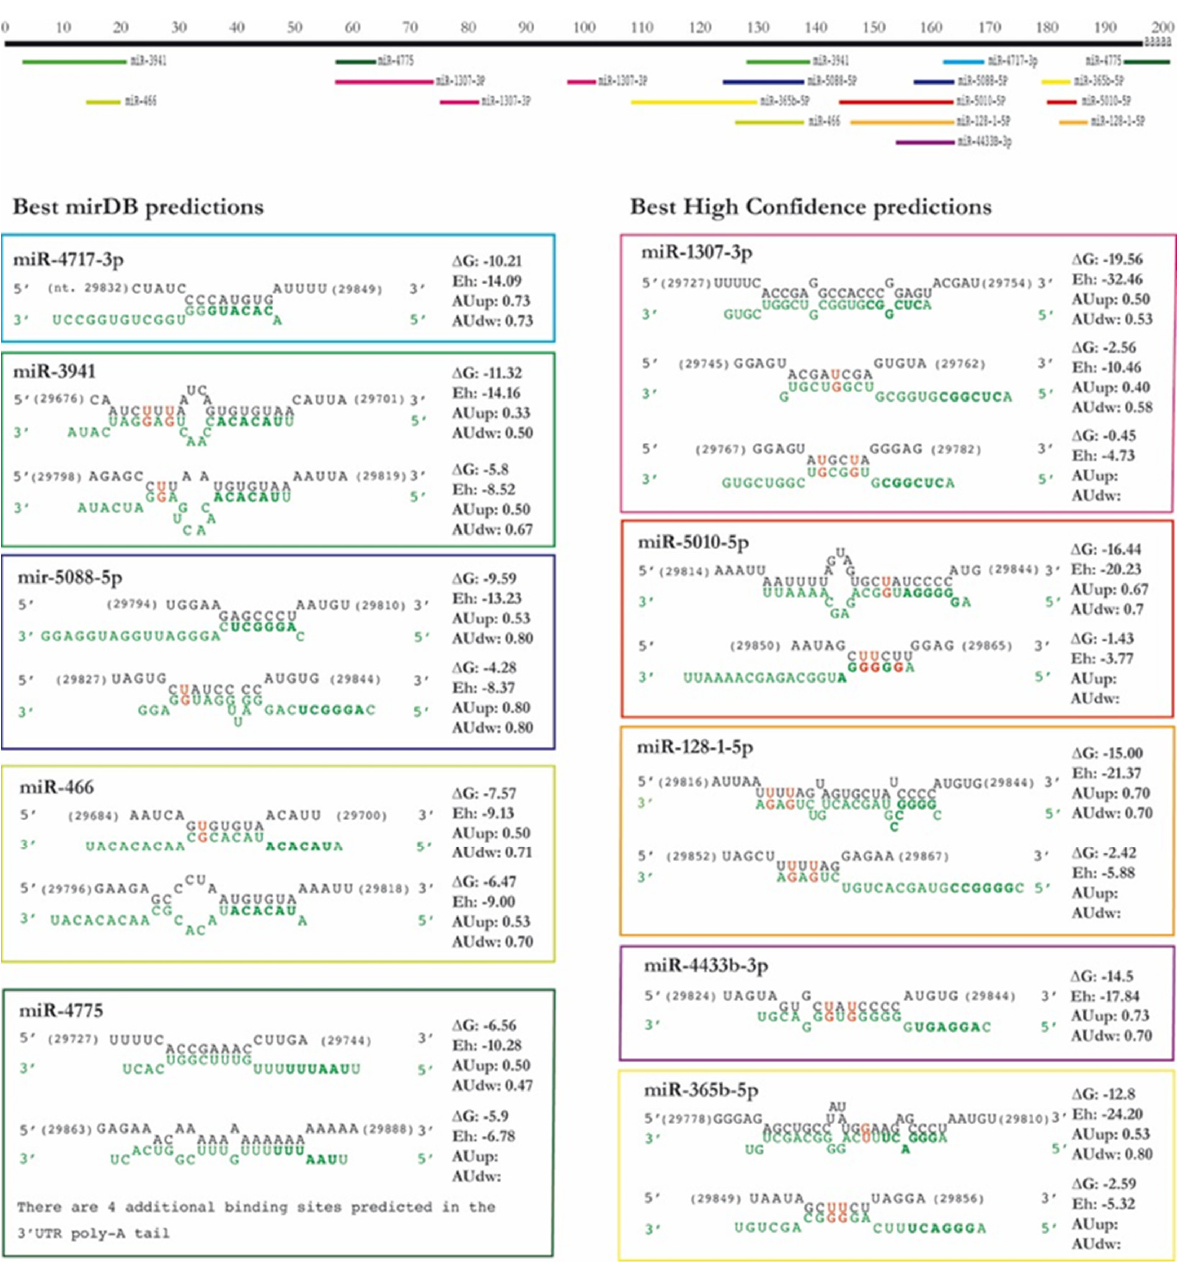
Figure 1. Predicted bindings of the selected microRNAs in the SARS-CoV-2 3 ′ -UTR. The figure summarizes the information provided by the different predictive tools on location (derived from IntaRNA), sequence complementarity (IntaRNA and STarMir), free energy (IntaRNA), target site accessibility (IntaRNA and RNAhybrid), and AU content upstream and downstream (provided by STarMir). The viral 3 ′ -UTR sequence is written in black, whereas the human microRNA sequence appears in green type, microRNA seed regions appear in bold type, and GU unions are shown in red. The position of the binding regions in the 3 ′ -UTR (without poly-A, in black) for each mi- croRNA appears represented in the upper part of the figure.